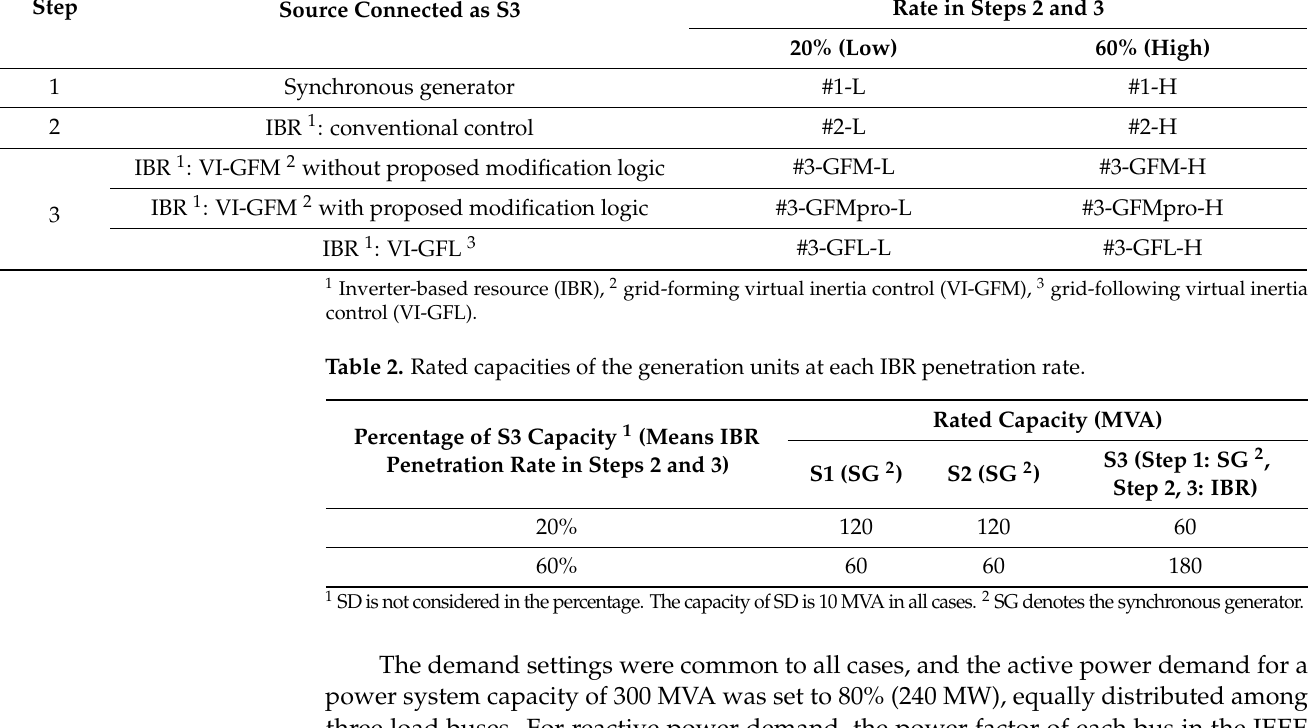
Table 1. Indices of the simulation study.